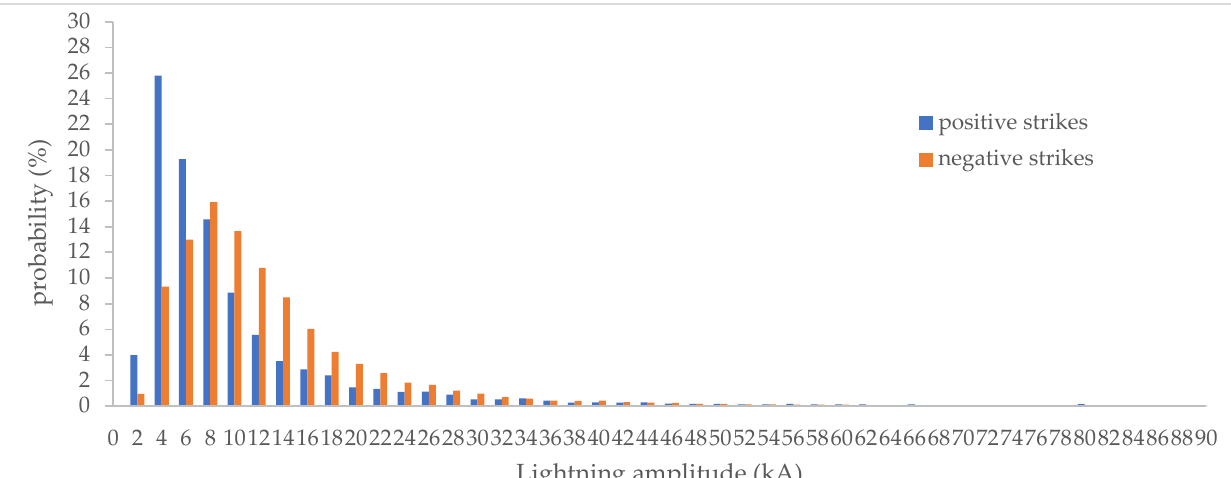
Figure 6. Αmplitude probability distribution from the total of the ten (10) WPs within Hellenic territory.